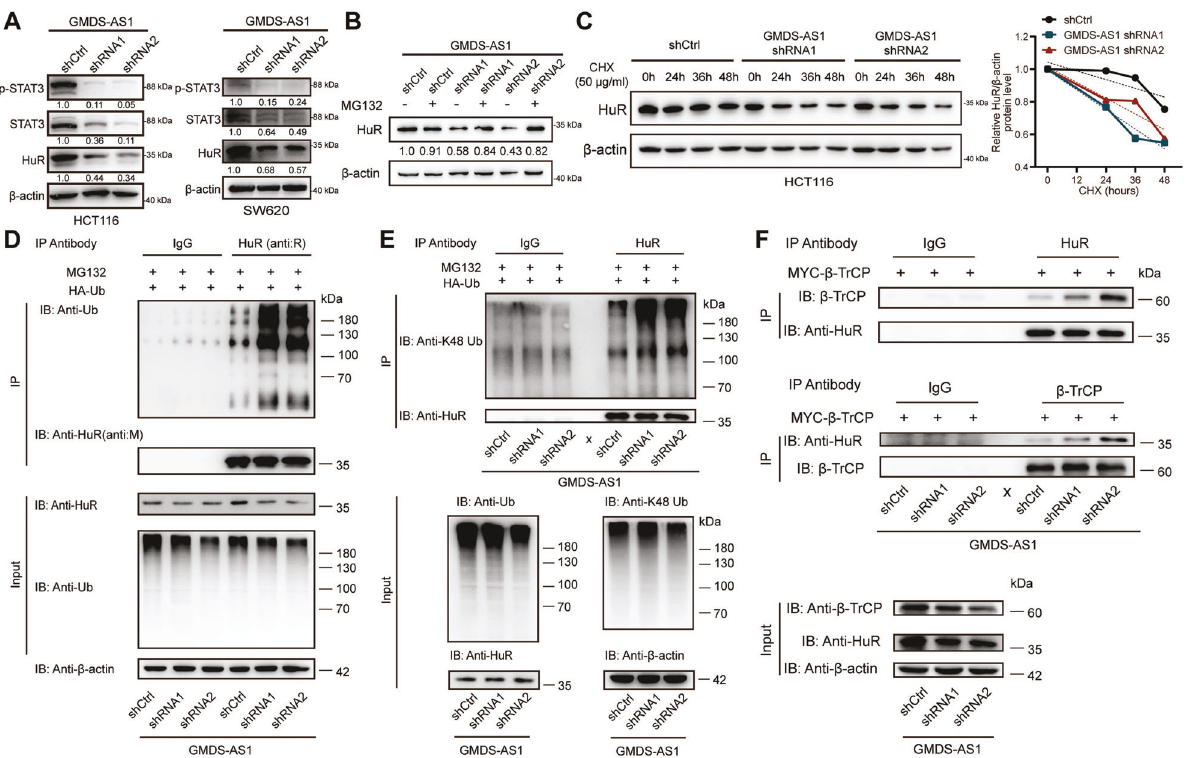
Fig. 6 GMDS-AS1 blocks ubiquitination-dependent proteasomal degradation of HuR. A The protein levels of HuR, p-STAT3 (Y705) and total STAT3 in HCT116 cells (left) and SW620 cells (right) stably transduced with control or GMDS-AS1 shRNA were detected by immunoblotting. β -actin was the endogenous control. B GMDS-AS1 control/KD HCT116 cells were treated with MG132 (50 μ g/ml) or dimethyl sulfoxide (DMSO) for 8 h, and the protein level of HuR was detected by immunoblotting. Densitometric analyses were performed with ImageJ software. The relative level of HuR protein expression was calculated and is labeled below the charts (normalization on the basis of the β -actin expression level). C GMDS-AS1 control/KD HCT116 cells were treated with CHX (50 μ g/ml) for the indicated times, and the protein expression level of HuR was detected by immunoblotting (left). Densitometric analysis curve of the HuR protein expression levels (right). β -actin was the endogenous control. D , E Immunoprecipitation (IP) experiments were performed to detect the polyubiquitination and K-48 polyubiquitination levels of HuR after GMDS-AS1 expression was knocked down in HCT116 cells. HCT116 cells stably transduced with control or GMDS-AS1 shRNA were transfected with hemagglutinin (HA)-ubiquitin (Ub)-expressing plasmids for 48 h. After treatment with 20 μ M MG132 for 8 h, cell lysates were immunoprecipitated with either control IgG or an anti-HuR antibody and immunoblotted with an anti-ubiquitin antibody ( D ) and an anti-K48- Ub ( E ) antibody. HuR, Ub, K48-Ub and β -actin were the loading controls. F IP experiments were performed to detect an interaction between HuR and β -TrCP1 after GMDS-AS1 expression was knocked down in HCT116 cells. HCT116 cells stably transduced with control or GMDS-AS1 shRNA were transfected with MYC- β -TrCP-expressing plasmids for 48 h. The cell lysates were immunoprecipitated with control IgG and